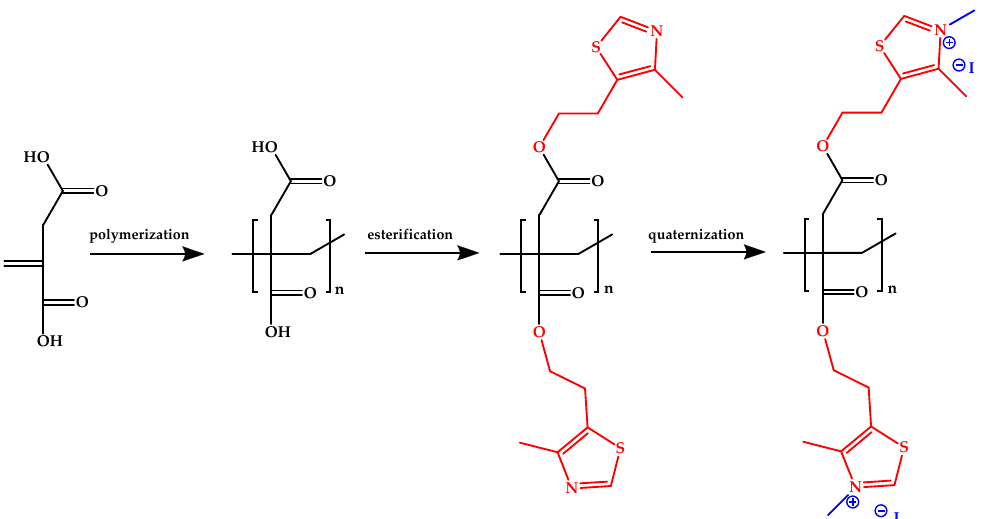
Scheme 1. Different steps of the quaternized polymers’ synthesis.